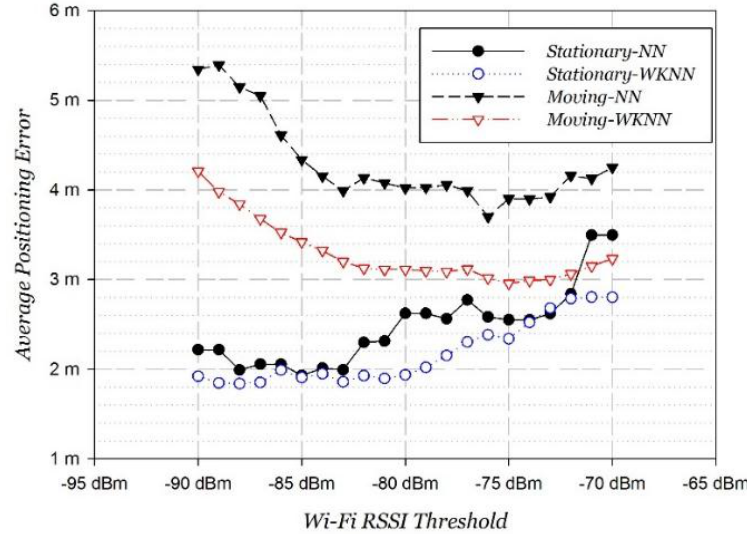
Figure 12. Wi-Fi positioning performance with RSSI threshold.